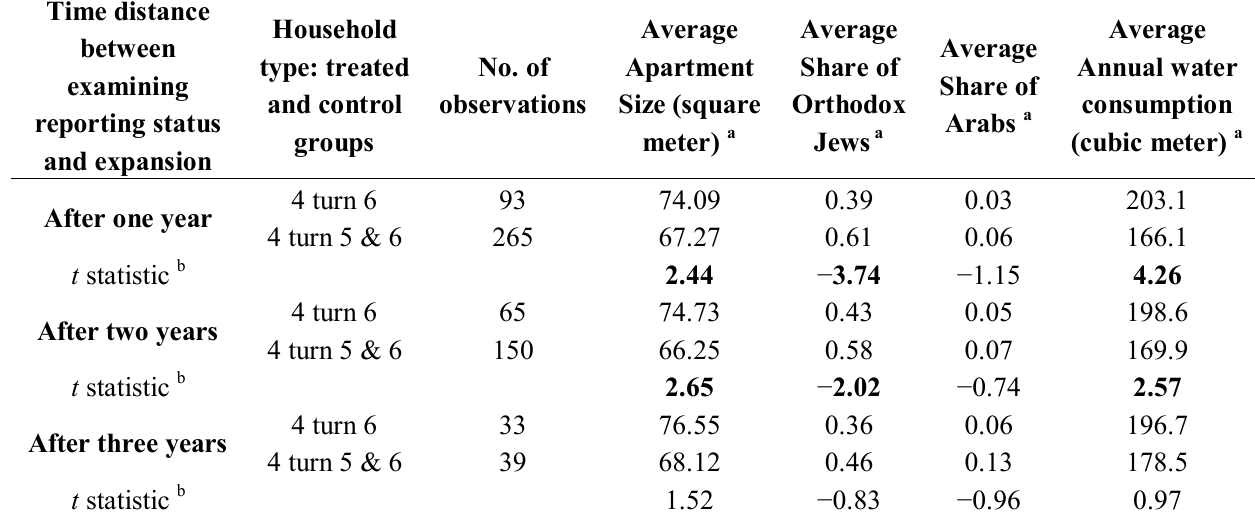
Table 3. Comparison of treated and control